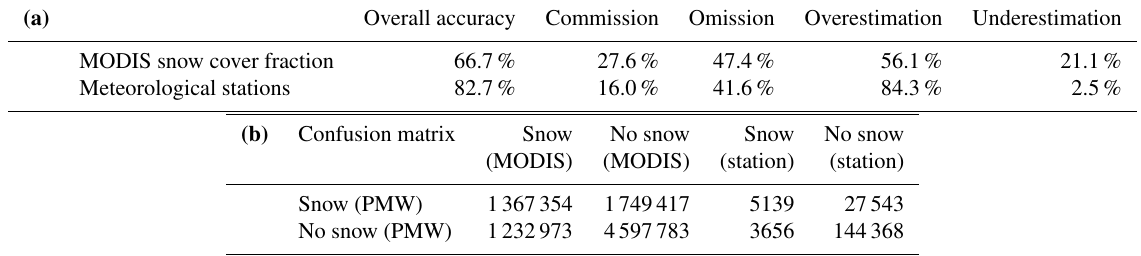
Table 1. Errors in derived snow cover from AMSR-E based on MODIS snow cover fraction and meteorological stations (a) and corresponding confusion matrix (b)